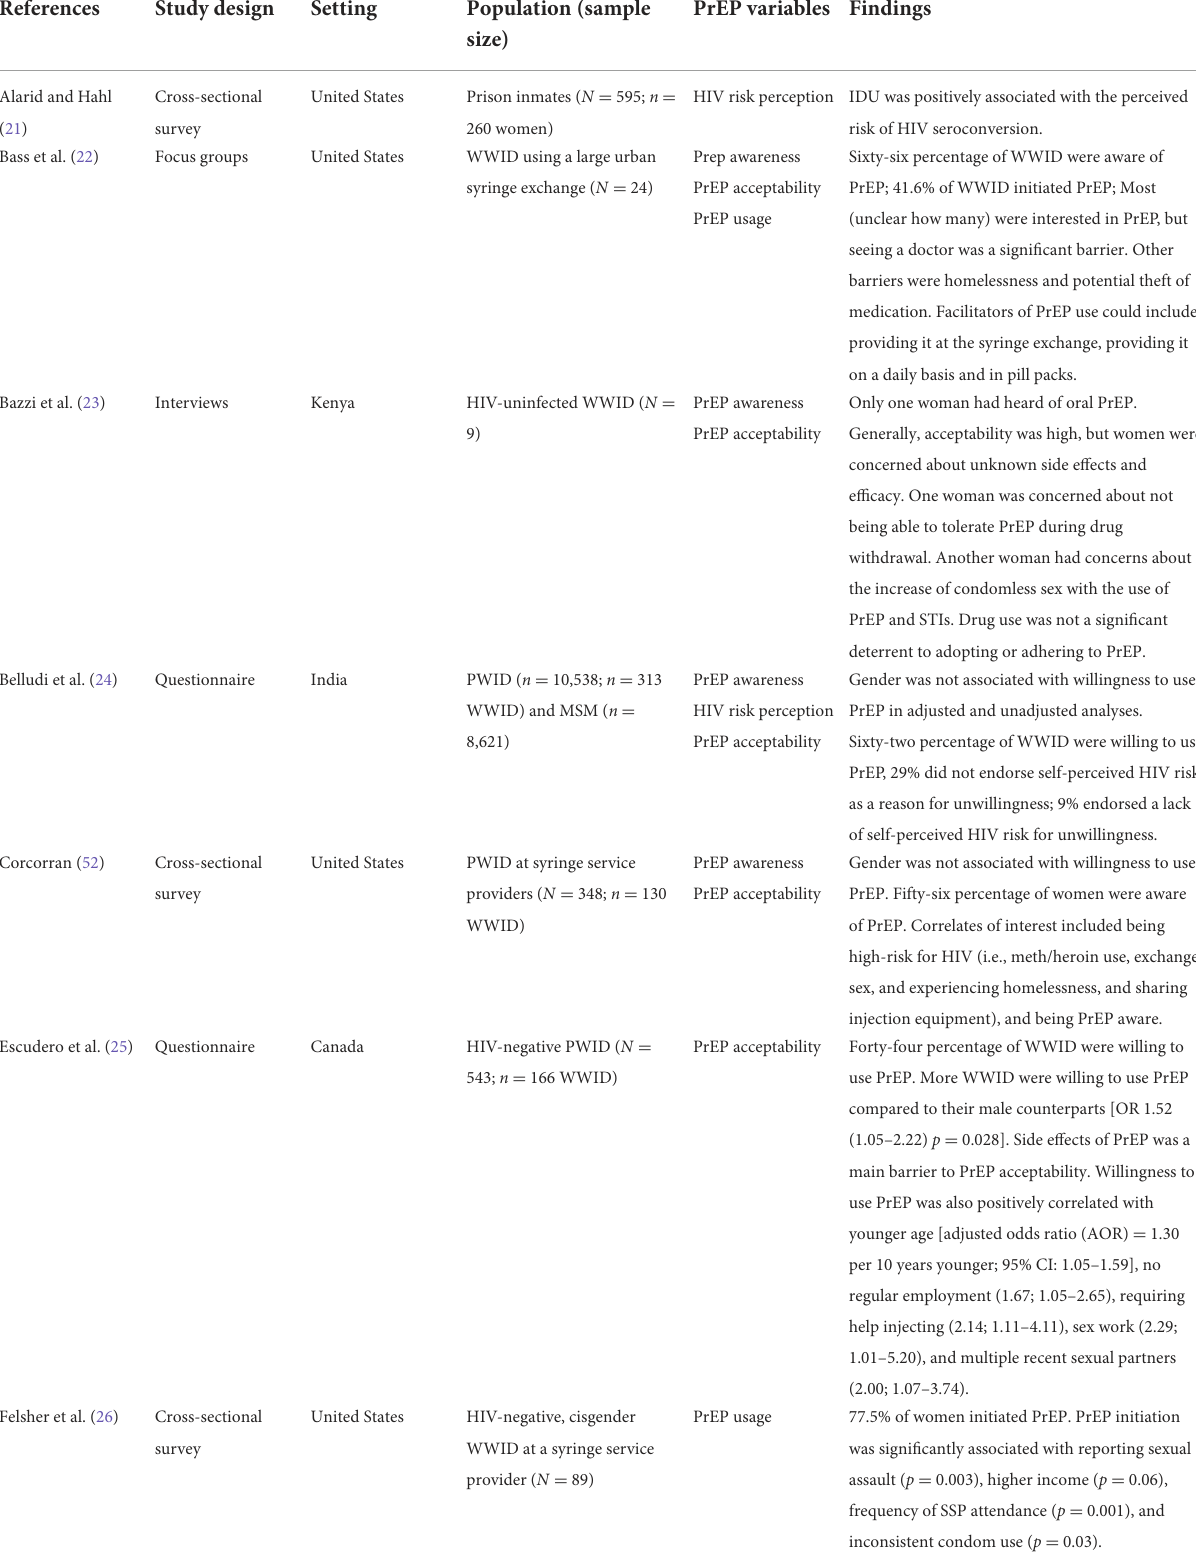
TABLE 2 Characteristics of included